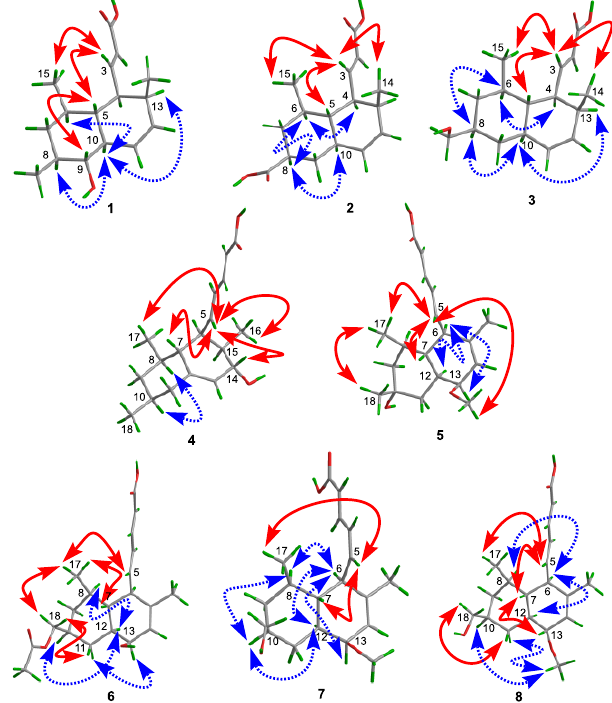
Figure 3. Key NOESY correlations of compounds 1 – 8 .